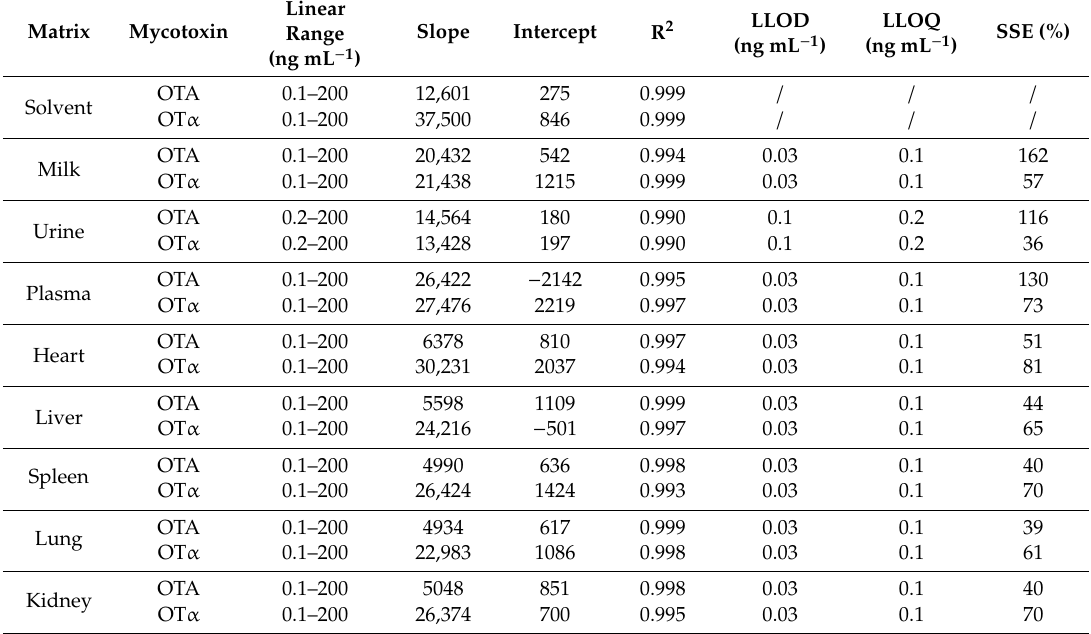
Table 1. Linearity, lower limit of detection (LLOD), and lower limit of quantification (LLOQ), matrix e ff ect (SSE) of ochratoxin A (OTA) and ochratoxin α (OT α ).